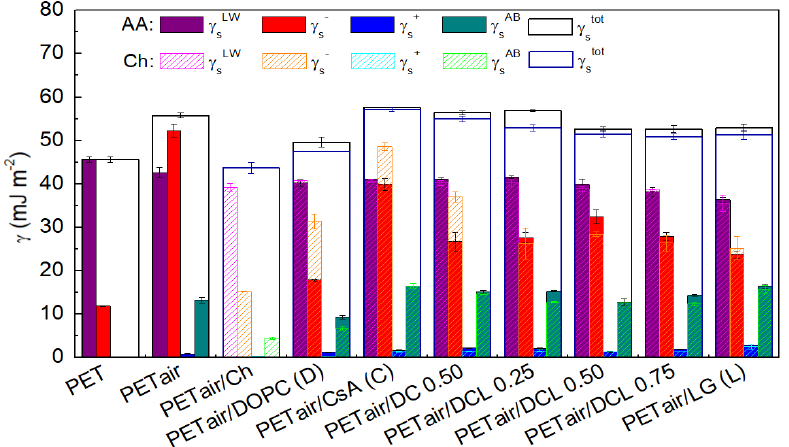
Figure 12. Surface free energy and its components calculated based on the LWAB approach for the unmodified and modified by the LB layers deposited from the air/AA and air/Ch interfaces onto the PET surfaces.